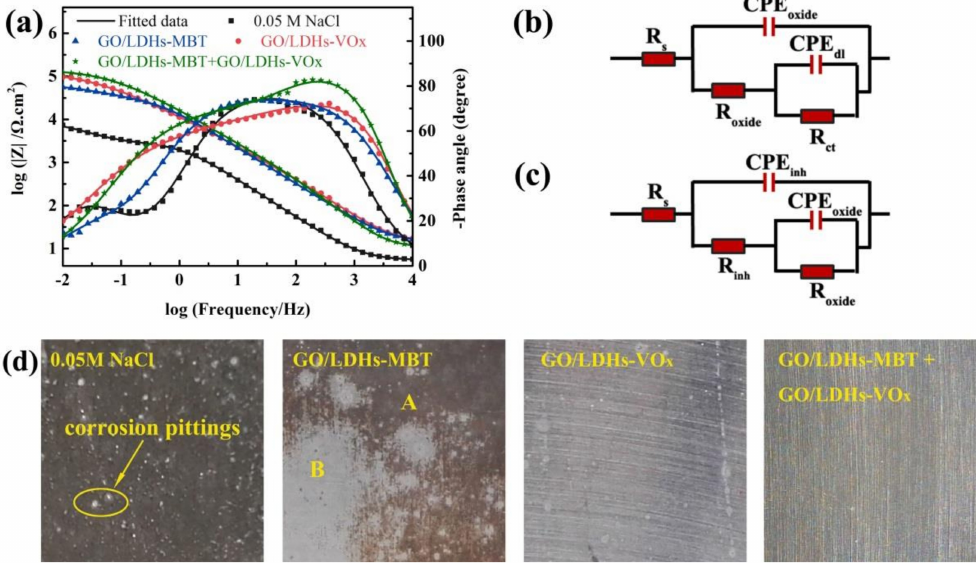
Figure 5. ( a ) Electrochemical impedance spectroscopy (EIS) spectra of bare AA2024 after immersion for two days in 0.05 M NaCl with and without nanofillers; ( b ) equivalent electrical circuits used for fitting in 0.05 M NaCl and ( c ) 0.05 M NaCl with nanofillers; and ( d ) optical photos of the AA2024 surface after immersion for 10 days in 0.05 M NaCl doped with different